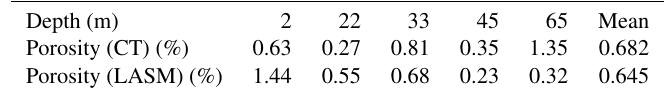
Table 2. Porosity values (%) for each ultrasonic sample (derived from CT measurements) and the corresponding COF thin sections (derived from LASM scans with a vertical offset of 10–15cm to CT-samples).